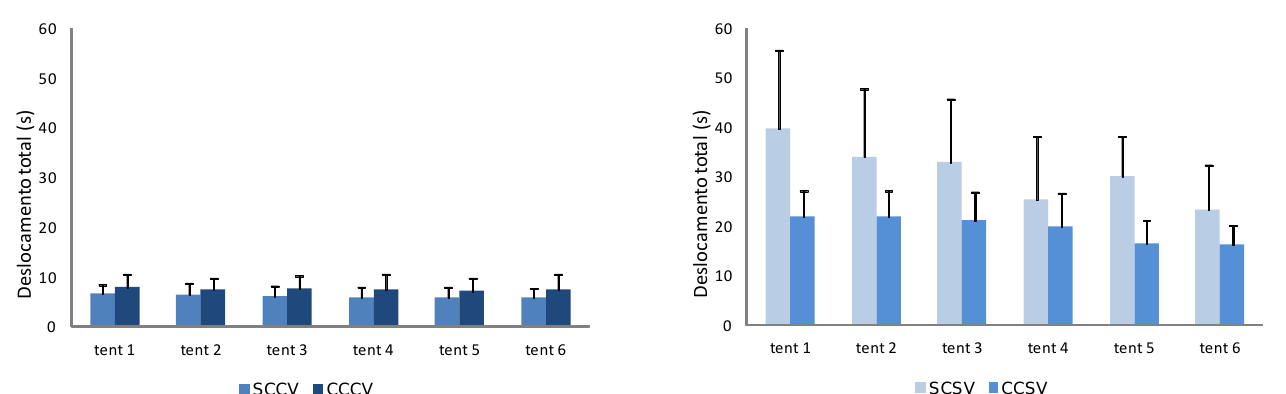
Figura 1. Média e desvio-padrão da duração do deslocamento total nas condições experimentais com e sem o cão, mas com uso da visão (lado esquerdo) e com e sem o cão, mas sem o uso da visão (lado direito).